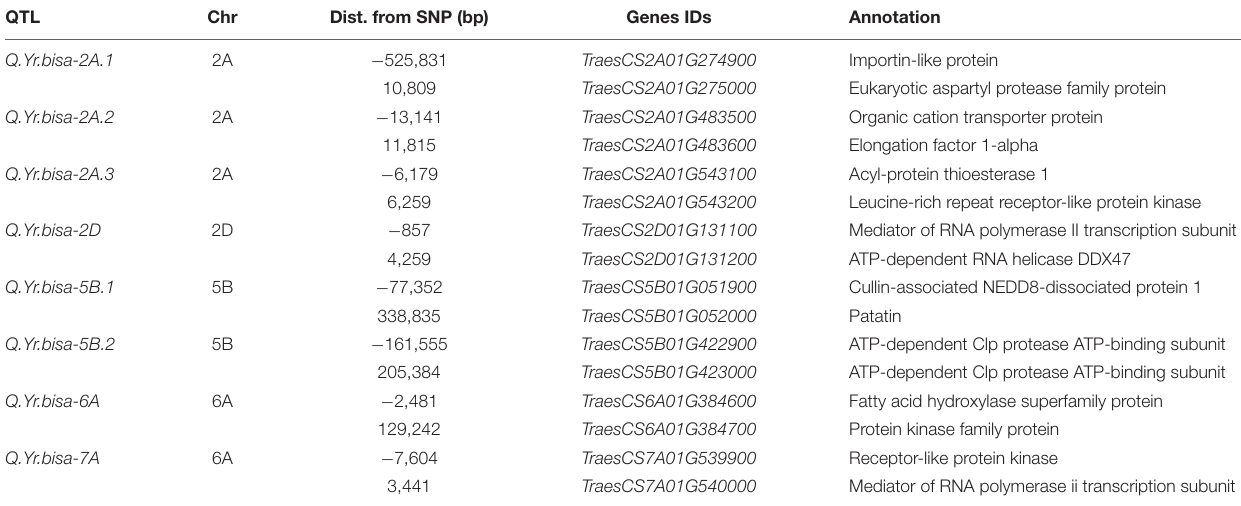
TABLE 4 | Summary of genes found adjacent to SNPs associated with the QTLs mapped in the present study based on the gene annotation using wheat reference sequence (RefSeq v1.0) annotation database. QTL Chr Dist. from SNP (bp) Genes IDs Annotation